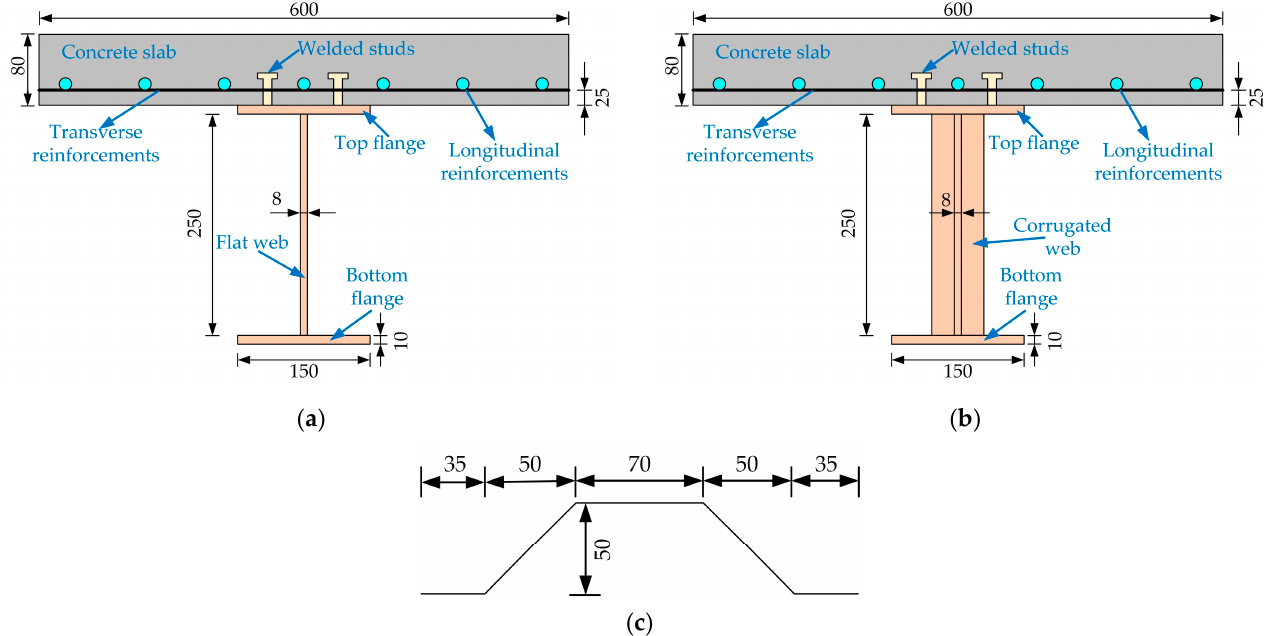
Figure 2. Dimension details of composite girders: ( a ) composite girders with flat webs; ( b ) composite girders with corrugated webs; ( c ) corrugated web profile (unit: mm).